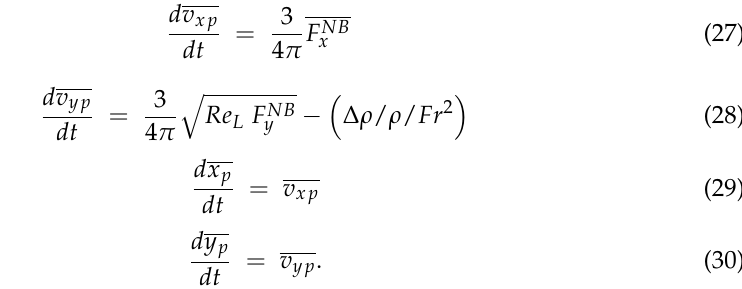
√ Re L . Only three plate lengths are ; light– ∆ ρ / ρ < Fr 2 / L